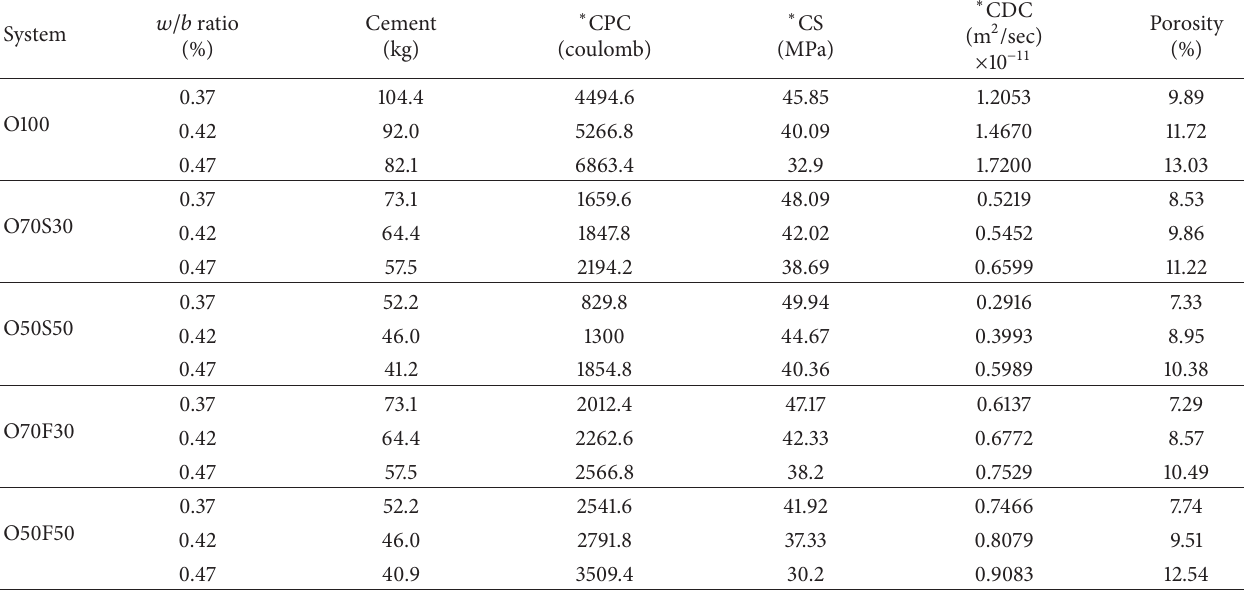
Table 4: Result of compressive strength, charge passed coulomb, chloride diffusion coefficient, and porosity of concrete.